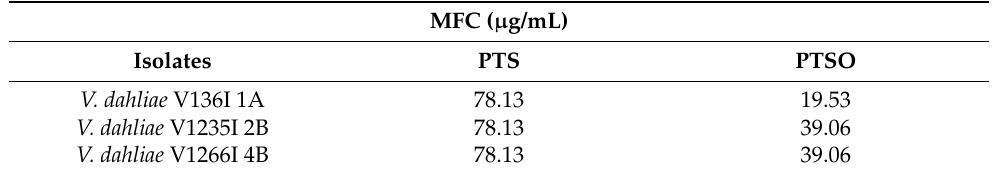
Table 3. Minimum Fungicidal Concentration (MFC) against different isolates of Verticillium dahliae .